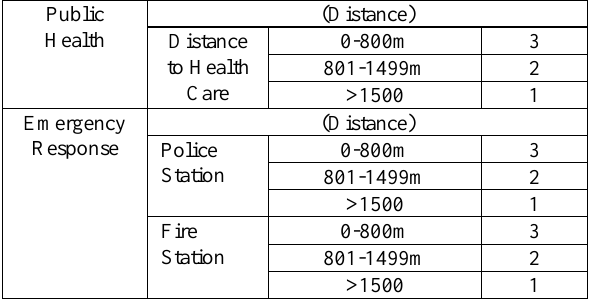
Table 5. Indicators, sub-indicators, condition and scoring to assess the safety level for campus.